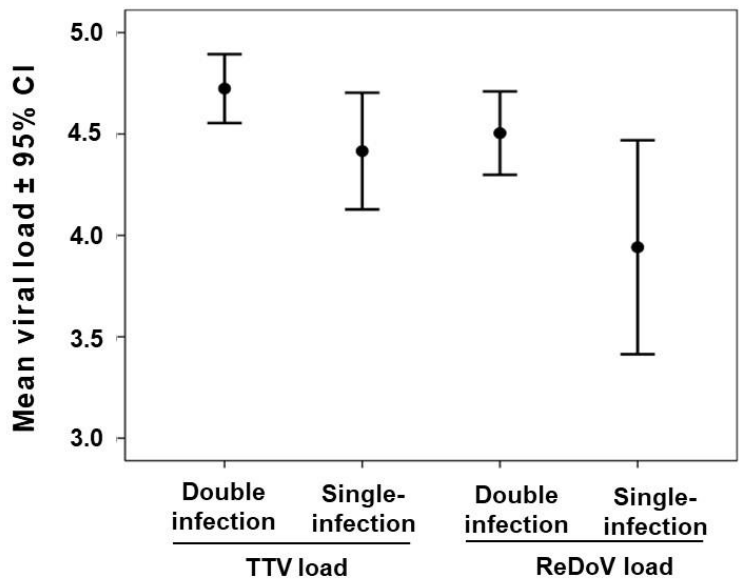
Figure 1. TTV and ReDoV loads of 313 saliva samples, stratified by the number of viruses carried. Viral load is expressed as the mean log DNA copies per ml of saliva ± confidence intervals (CI).